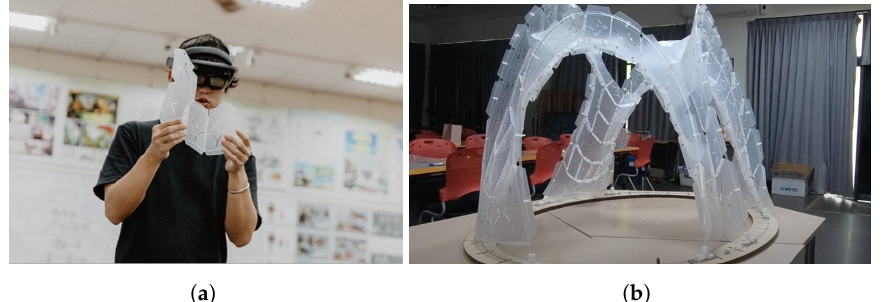
Figure 10. Users discussing the prototype and the final result. ( a ) Assemblers use HoloLens; ( b ) 300 × 300 × 300